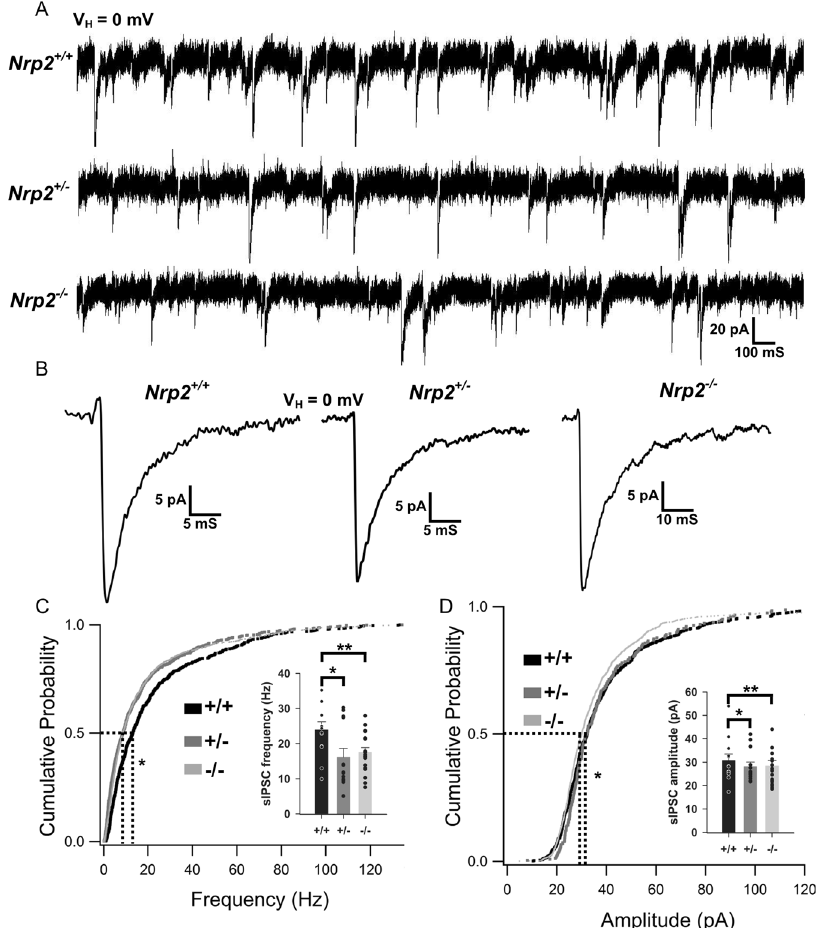
Fig. 4 Differences in pyramidal cells sIPSC frequency and amplitude between Nrp2 knockouts, heterozygotes and wild-type littermates. A Representative sIPSC traces from CA1 pyramidal cells of Nrp2 + / + , Nrp2 + / − and Nrp2 − / − . B Representative average sIPSC traces from the three groups. C Cumulative Probability plots for frequency of sIPSCs in Nrp2 + / + ( n = 12), Nrp2 + / − ( n = 13) and Nrp2 − / − (n = 19). Inset, summary bar plot showing the frequency of sIPSCs from the three genotypes. D Cumulative Probability plots for amplitude of sIPSCs in Nrp2 + / + ( n = 12), Nrp2 + / − ( n = 15) and Nrp2 − / − ( n = 19). * indicates p < 0.05 by Kolmogorov – Smirnov